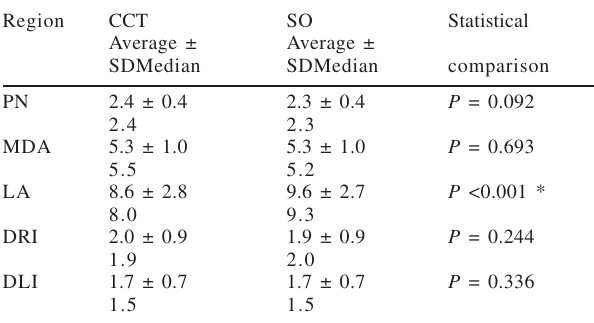
Table 2 - Comparison between conventional computerized tomography (CCT) measurements and surgical observation (SO) (n = 20).